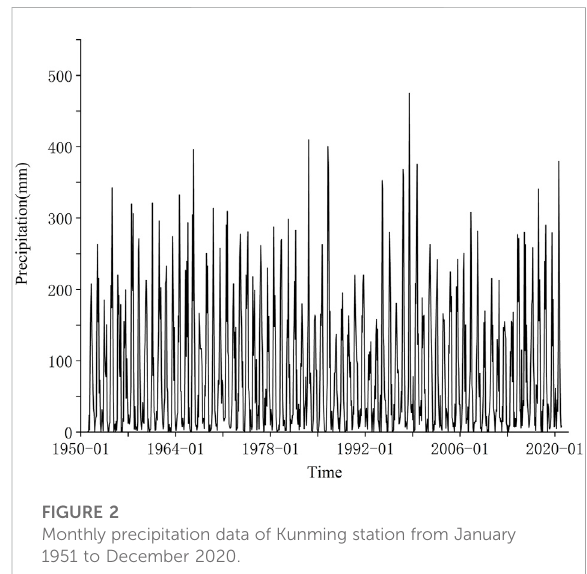
FIGURE 2 Monthly precipitation data of Kunming station from